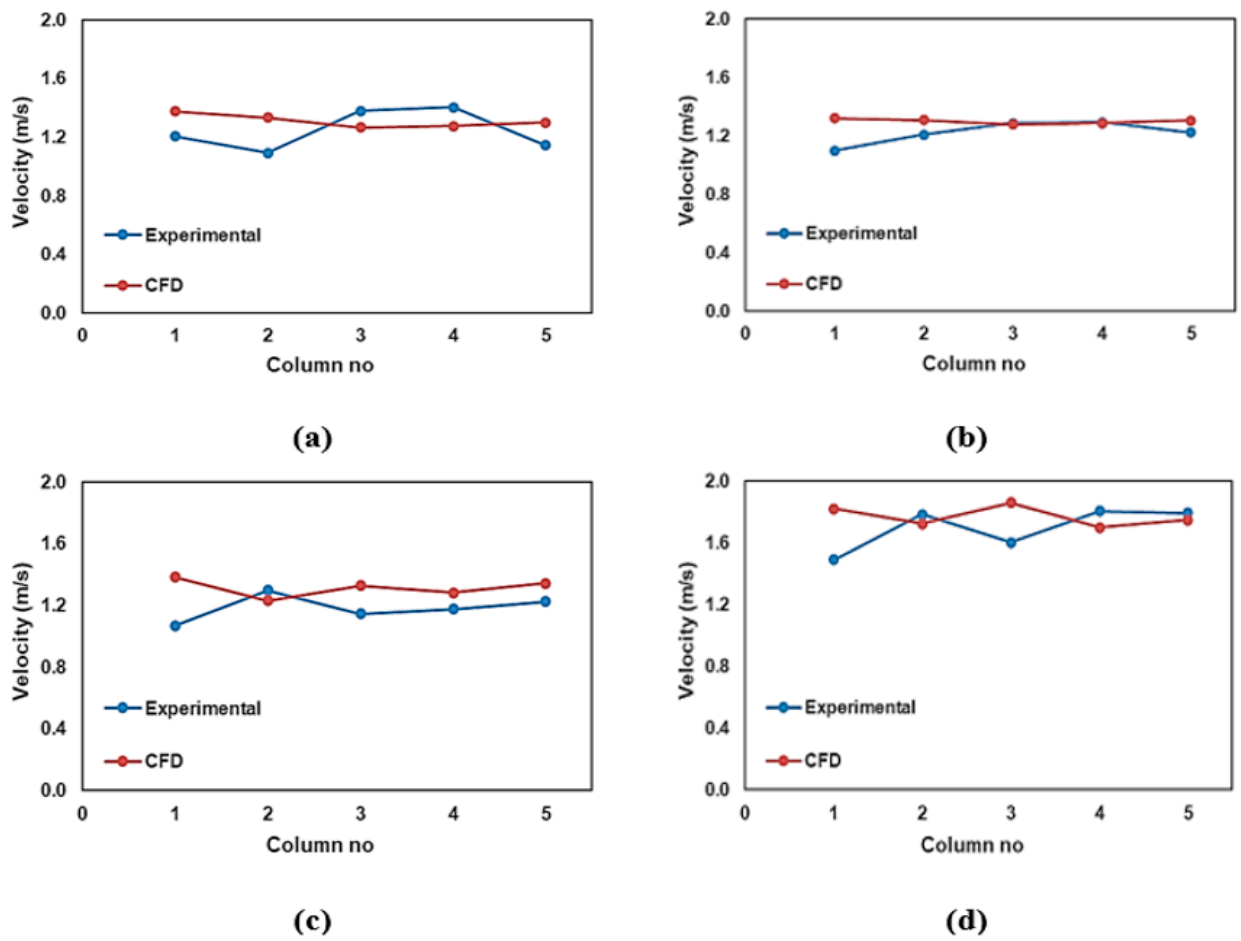
Figure 14. CFD and experiment results for velocity fluctuations: ( a ) Cross-section 1; ( b ) Cross-section 2; ( c ) Cross-section 3; ( d ) Cross-section 4.